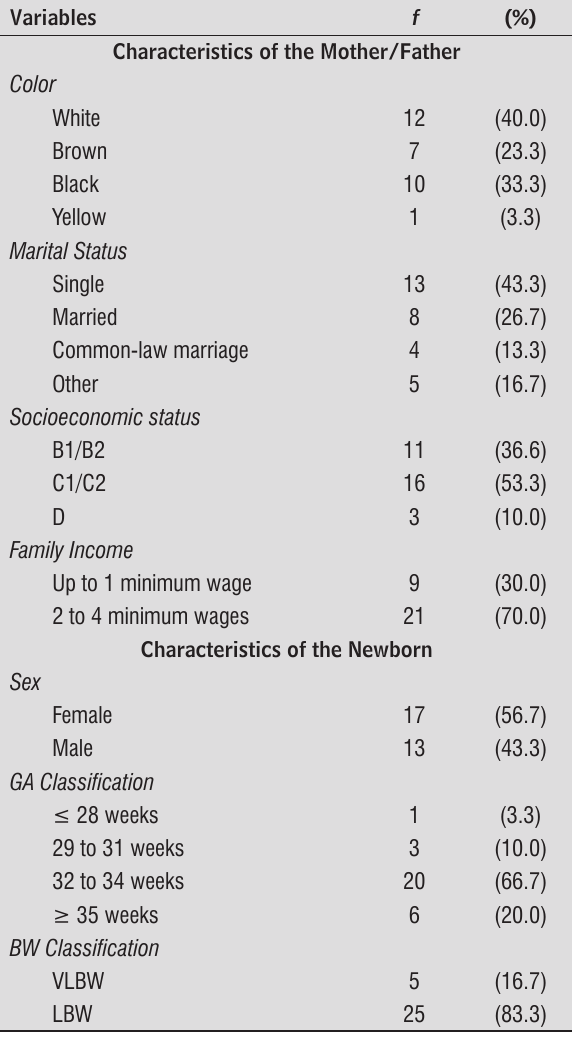
Table 1 - Descriptive characteristics of the